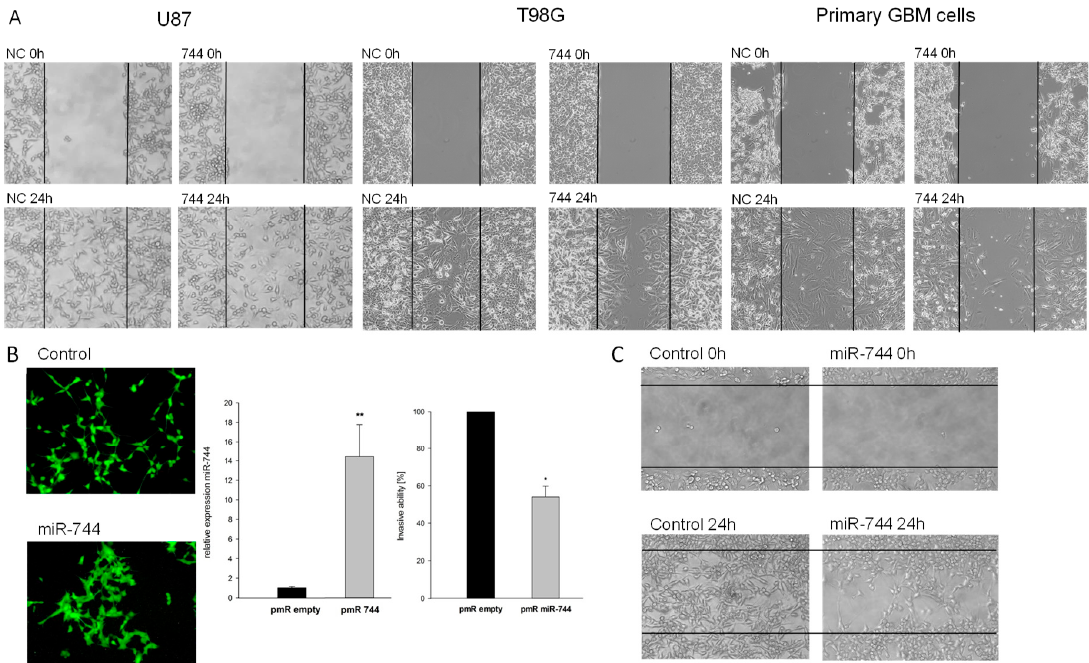
Figure 2. Overexpression of miR-744 induces focal cell growth and inhibits invasion and migration. ( A ) 2D migration assays of transiently miR-744 transfected cells (left panel: U87; middle panel: T98G; right panel: primary GBM cell lines) at start and after 24 hours. Lines mark the initially cell-free area. A typical example of 3 experiments is shown. ( B ) Fluorescence microscopy of control and stably miR-744 overexpressing cells. ( C ) 2D migration assays of stably transfected cells; depicted are start state and after 24 hours of incubation. Lines mark the cell-free area. A typical example of 3 similar experiments is shown. ( D ) Left panel: MiR-744 levels after stable transfection (induction 14.4-fold ± 6.0, n = 5, p < 0.001). Right panel: Invasion after stable transfection of U87 cells, measured with Collagen-coated Boyden Chamber invasion assays (n = 4, p = 0.029). ** p < 0.001; * p < 0.05.